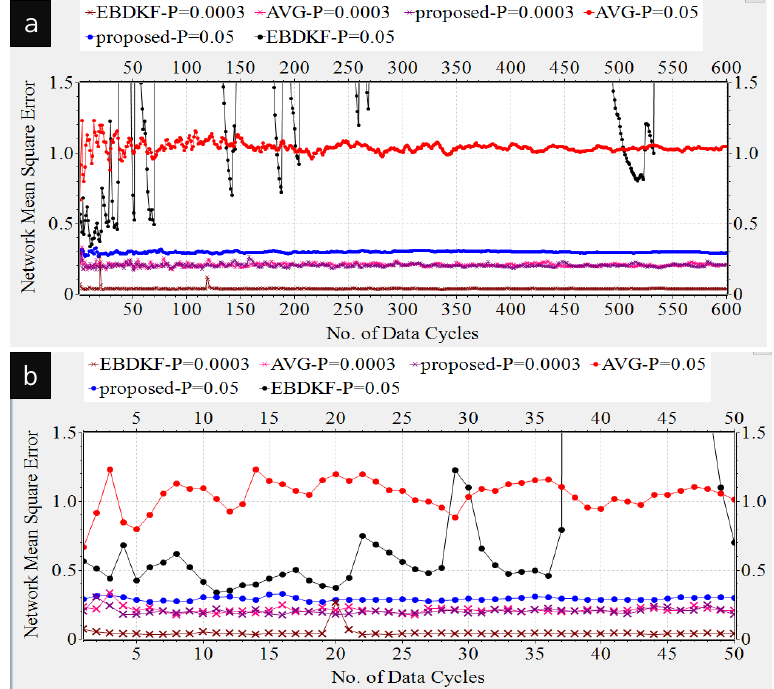
Figure 14. Network MSE vs. the number of data gathering cycles for BER of 0.0003 and 0.05 among the proposed statistical, AVG and EBDKF information fusion methods in a tree-based IoT platform: ( a ) for first 600 data gathering cycles and ( b ) for first 50 data gathering